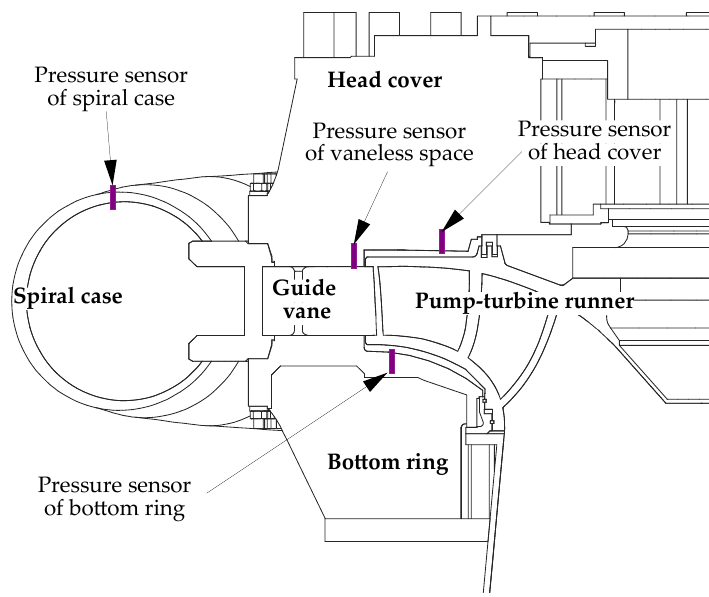
Figure 2. Locations of the installed pressure sensors of the PT unit (sectional